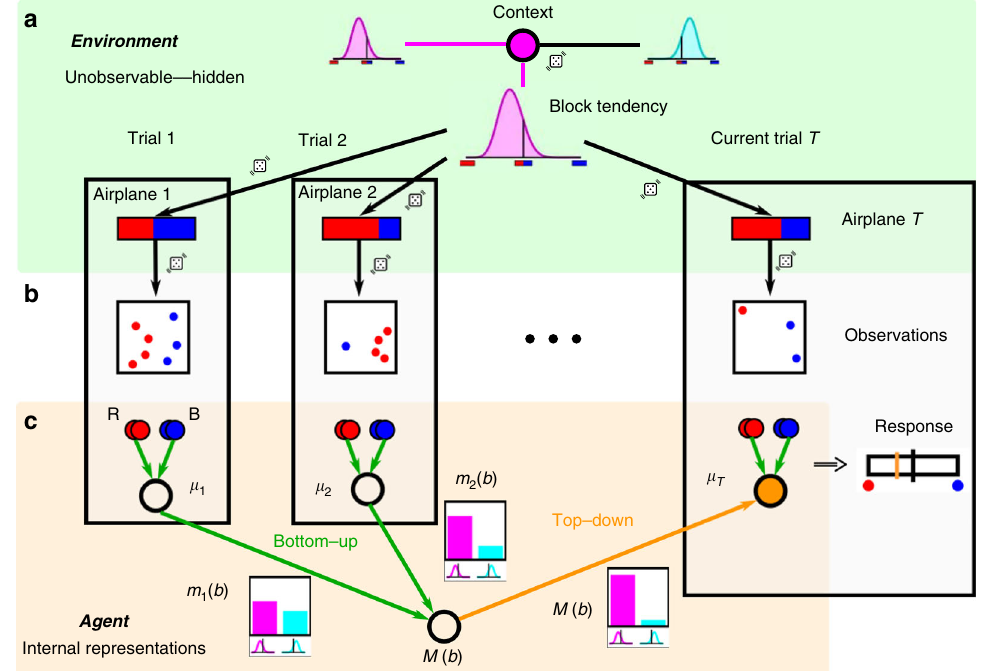
Fig. 3 Schematic of the hierarchical structure for learning empirical priors Participants are told that across a block of fi ve trials (1, 2, … T ≤ 5) they will see passengers from fi ve different airplanes arriving to the same airport. As before, they are asked to report their decision con fi dence whether the current airplane carried more red or blue passengers. The schematic illustrates the hypothetical examples of an ideal observer that estimates con fi dence based on the proportion of blue samples of the current airplane T and on the samples observed in previous trials. The generative model of the observations is as follows. a Within a block of fi ve trials, the context, called block tendency, is fi rst selected, which corresponds to choosing either a positively (magenta) or negatively (cyan) skewed distribution over airplane proportions. This context (distribution) is maintained throughout the block of fi ve trials, but on each trial a new blue majority (blue-red horizontal bars indicating the passenger proportion in each airplane) is randomly sampled from that distribution. In the example, the context favors airplanes of red majorities. b Sample generation given the airplane majority is the same as for the previous task. c The internal representation of the agent (orange background) mirrors the dependence structure in the environment (green background). Probabilistic inference is performed by message passing between the nodes which internally represent the inferred block tendency and the airplane ’ s passenger proportion of each trial (see Methods). Previous trials ( t < T ) provide evidence about the block tendency through the messages m t ( b ). They are probabilistically integrated into an overall belief about the block tendency M ( b ) which provides top-down constraints on the inference of a new airplane ’ s blue proportion (orange node). The con fi dence in a blue majority of the current airplane T held by the ideal observer (response bar, right) should follow from both the current sample proportion and the inferred block tendency from previous